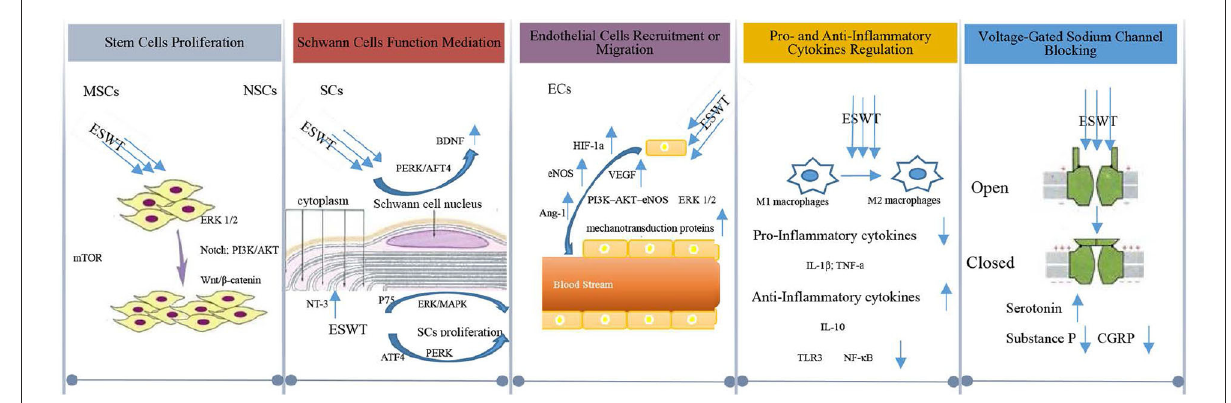
FIGURE3 Cellular and molecular mechanisms for the interaction of ESWT with